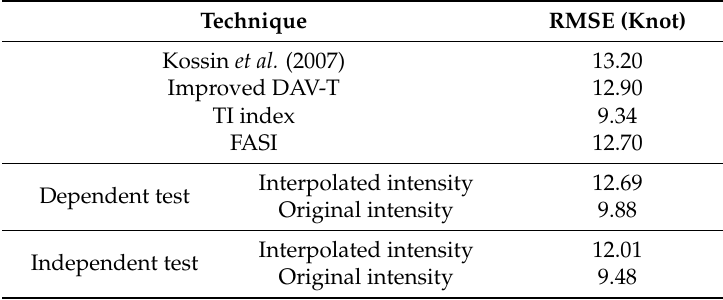
Table 7. Comparison of the model estimated typhoon intensities with previous developed technique using the statistics